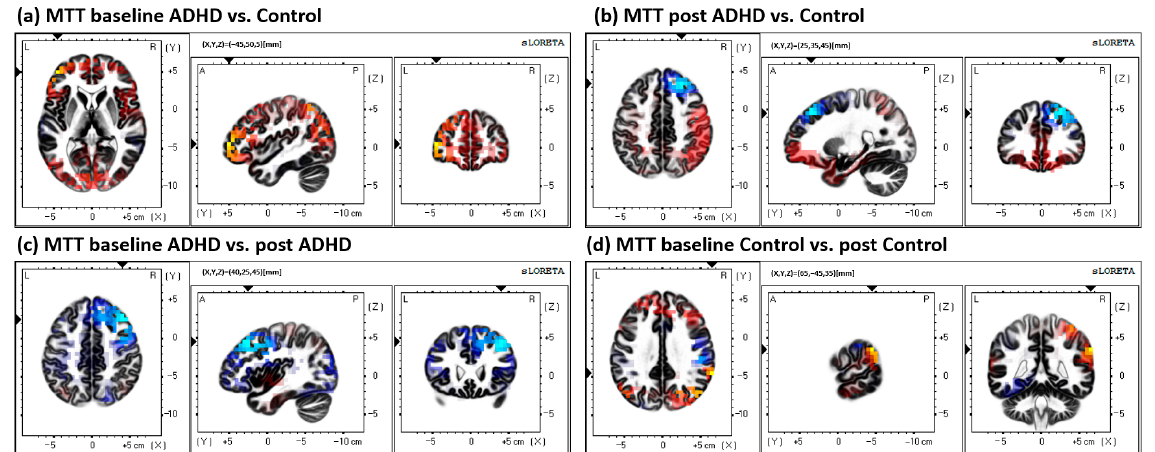
Figure 4. All MTT comparisons. All results yielded were insignificant ( p > 0.05). ( a ) Comparison of baseline activity between groups (ADHD vs. Control; control activity > ADHD activity), differential activity in BA 10, middle frontal gyrus, frontal lobe. ( b ) Comparison of post-acquisition activity between groups (ADHD vs. Control; control activity < ADHD activity); the greatest difference was found in BA 8, middle frontal gyrus, frontal lobe. ( c ) Within-group ADHD comparison of baseline activity to post-acquisition (baseline < post activity), differential activity found in BA 8, middle frontal gyrus, frontal lobe. ( d ) Within-group control comparison between baseline and post-acquisition (baseline > post), greatest activity difference in BA 40, supramarginal gyrus, parietal lobe.